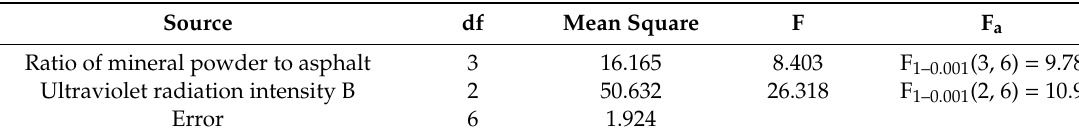
Table 6. Analysis for the ratio of asphalt mortar on 0.8–1.4.